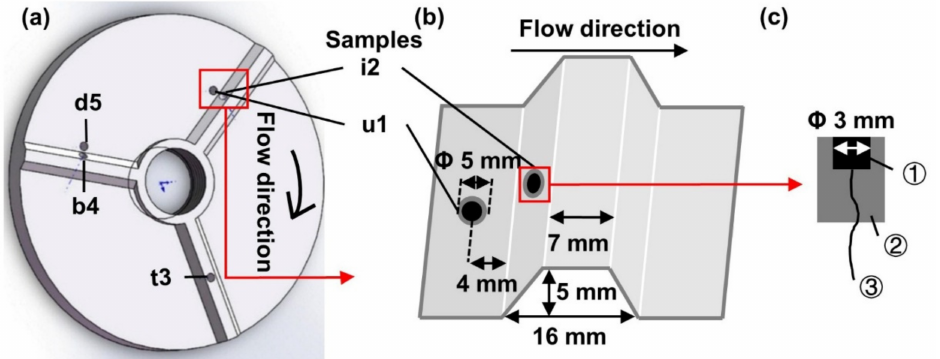
Figure 3. The sketch map of ( a ) the rotating disk with the samples on the (u1) upstream surface, (i2) incident flow surface, (t3) top surface, (b4) backflow surface, and (d5) downstream surface of the WRH, the size of ( b ) the trapezoidal protrusions with the skeleton map of the sample locations and ( c ) the electrochemical sample consisting of (1) specimen, (2) epoxy and (3) copper